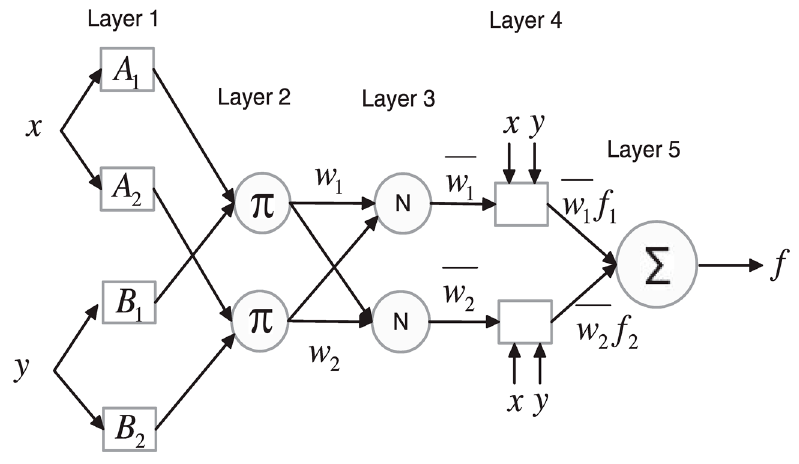
Figure 3. Basic ANFIS Structure.